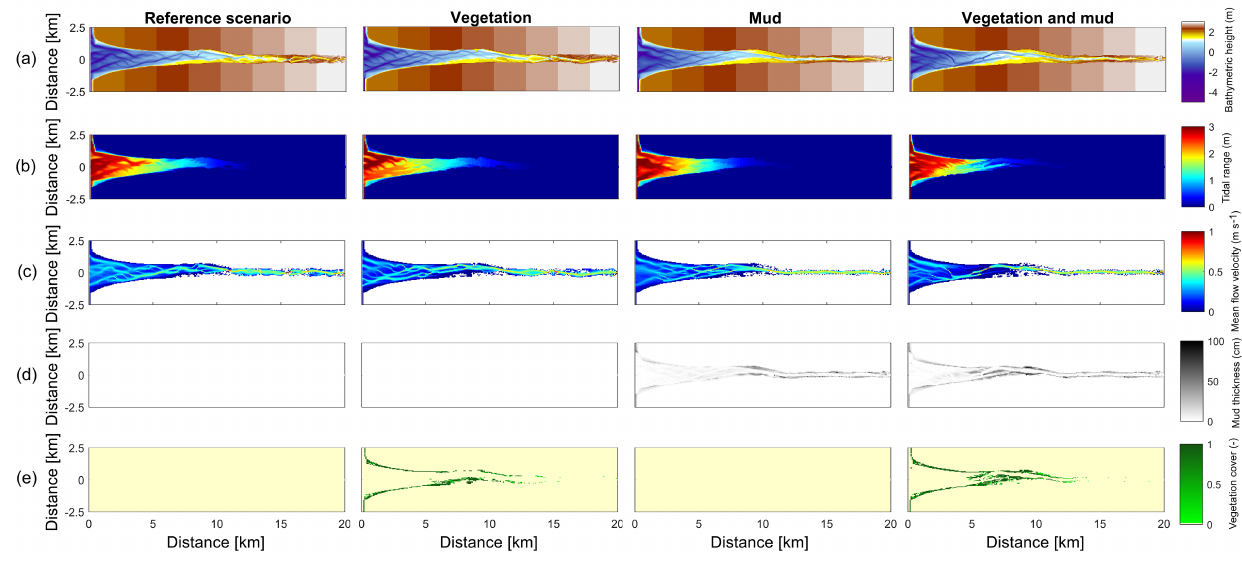
Figure 3. Results of the four scenarios after 100 years of simulation. (a) Morphology. Colours representing larger depths than − 5m were sat- urated to enhance contrast. (b) Tidal range. (c) Mean of absolute flow velocity during the tidal cycle. (d) Mud thickness in cm. (e) Vegetation cover at the surface, ranging from 0 to 1.